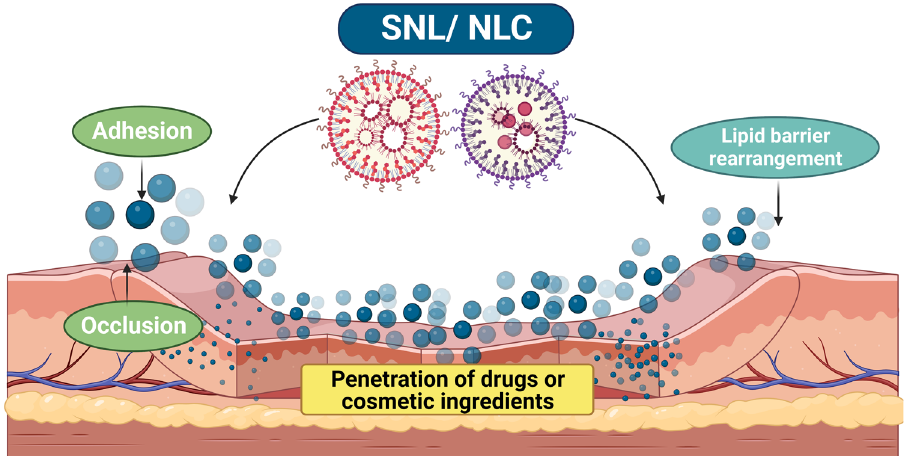
Figure 7: E ff ect of lipid NPs on the skin ( created with BioRender.com [ 15 ]) .